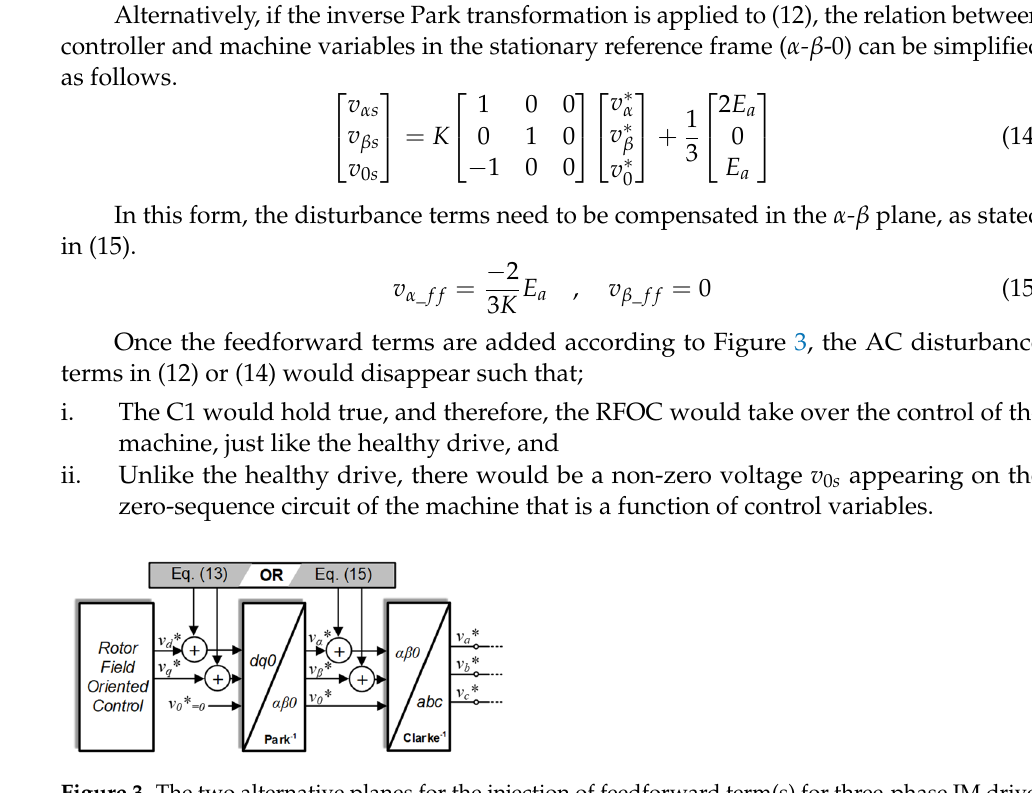
Figure 3. The two alternative planes for the injection of feedforward term(s) for three-phase IM drive. After adding the feedforward term stated in (13) or (15), the zero-sequence voltage